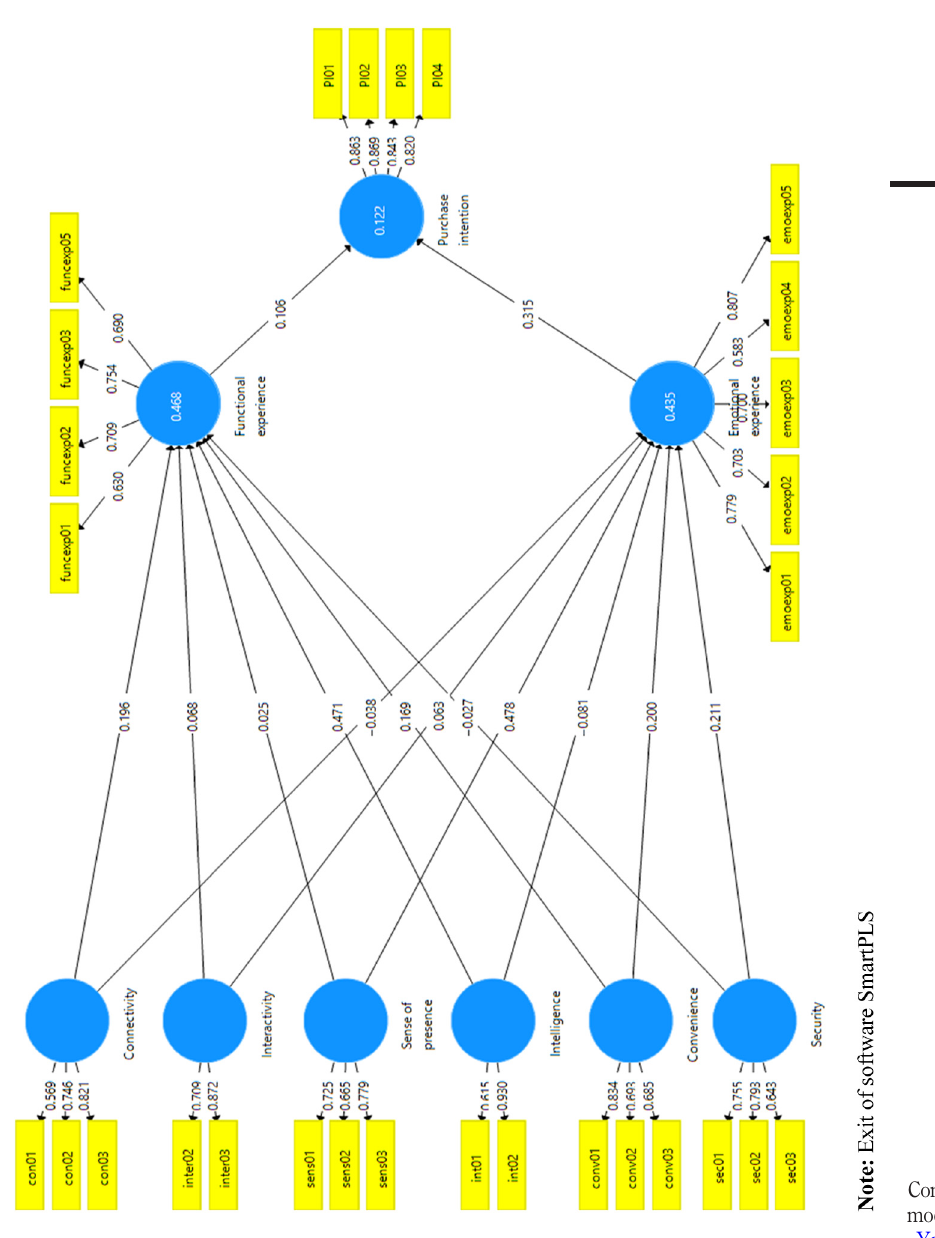
Figure 2. Convergent validity model adapted from Yaping et al.